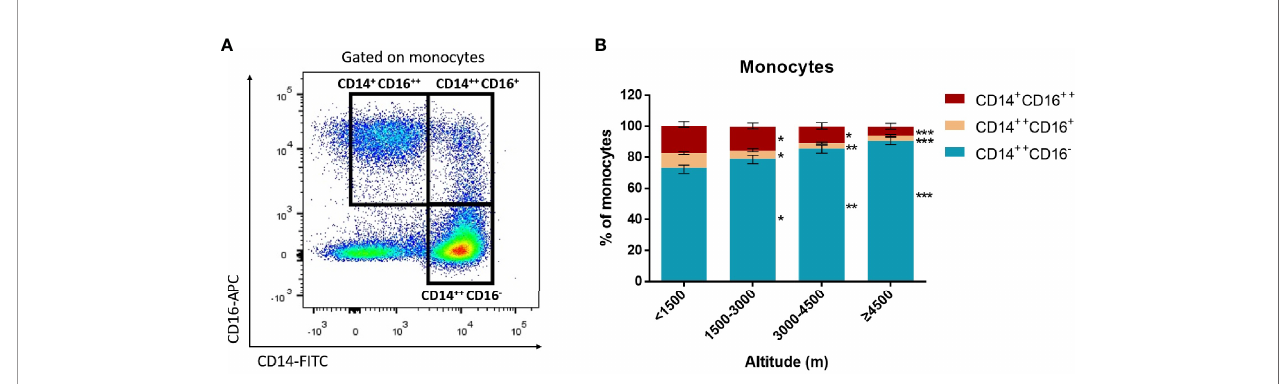
FIGURE 4 | Proportion of monocyte subsets among HAdV infectious patients at different altitudes. Comparison of monocyte subsets among HAdV infectious patients at different altitudes. (A) Representative FACS plots of the distributions of monocyte subsets distinguished by CD14 and CD16. (B) Comparison of monocyte subset distributions among HAdV infectious patients at different altitudes. The Kruskal – Wallis test (followed by post-hoc analysis with Dunnett ’ s t -test with Bonferroni adjustment) is applied to compare the differences between the low-altitude group (<1,500 m) and the other groups. * P < 0.05, ** P < 0.01, *** P